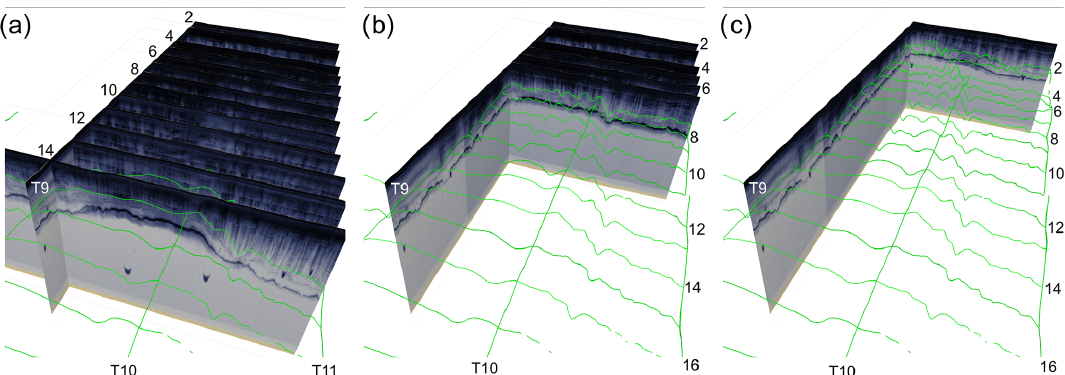
Figure 4. A 3D visualization of the picked (green lines) englacial layer R1, demonstrating the 3D pattern of folding and density of survey lines: (a) radargrams of across-ice-flow lines 14–2; (b) radargrams of across-ice-flow lines 7–2; (c) radargram of across-ice-flow line 2. Ice flow is into the page, and there is 105km between across-flow lines 14 and 2. The long down-ice tie line radargram shown in (a) – (c) is tie line 9 (Fig. 2c). Tie lines 9, 10, and 11 are